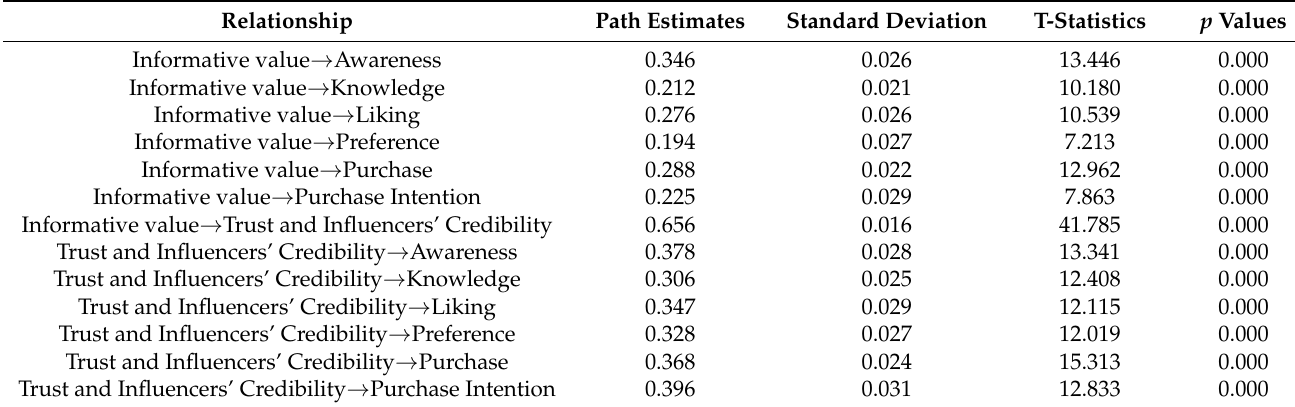
Table 5. Structural path estimates.